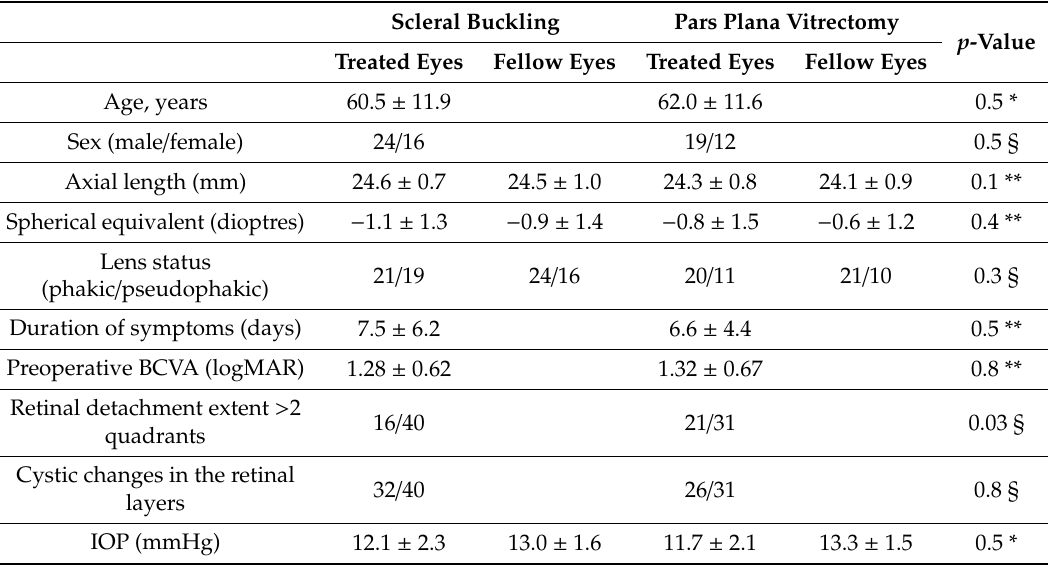
Table 1. Baseline clinical characteristics of treated and fellow eyes in the SB and the PPV